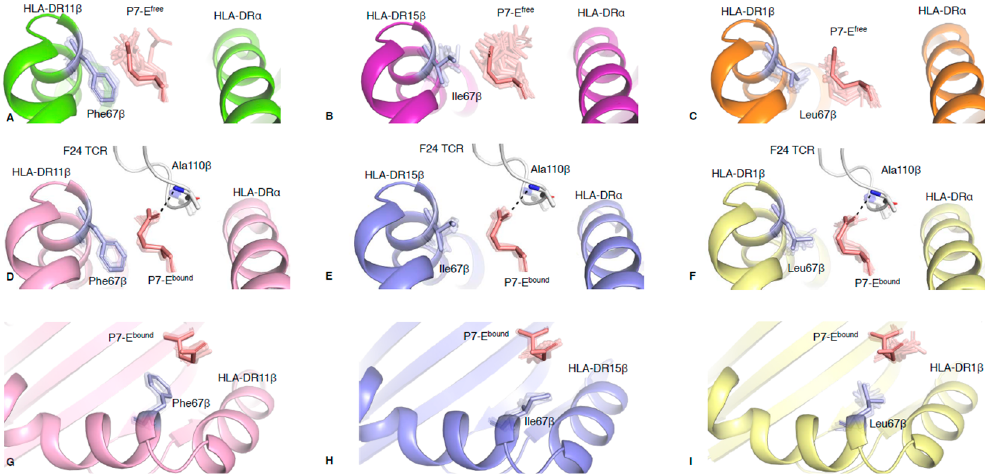
Figure 2. Conformational populations between side chain interactions of HLA-DR β 67 and P7-E. ( A – C ) Ensemble results of HLA-DR β 67 side chain (pale blue) interacting with P7-E residue (pale red) in the free state for ( A ) HLA-DR11-RQ13, ( B ) HLA-DR15-RQ13, ( C ) HLA-DR1-RQ13. ( D – I ) Ensemble results for F24 TCR-bound state of P7-E side chain (pale red) interacting with F24 TCR Ala110 β (white) and HLA-DR β 67 side chain (pale blue) for ( D ) HLA-DR11-RQ13 ( E ) HLA-DR15-RQ13 ( F ) HLA-DR1-RQ13. ( D , F ) the dashed lines show the hydrogen bonds between the P7-E and Ala110 β . ( G – I ) Top view of ensemble results for F24 TCR-bound state of HLA-DR β 67 side chain and P7-E residue of ( G ) HLA-DR11-RQ13, ( H ) HLA-DR15-RQ13, and ( I ) HLA-DR1-RQ13. The crystal structure conformation is represented as solid colour, and the ensemble models are represented in transparent, both with the same colour coding.